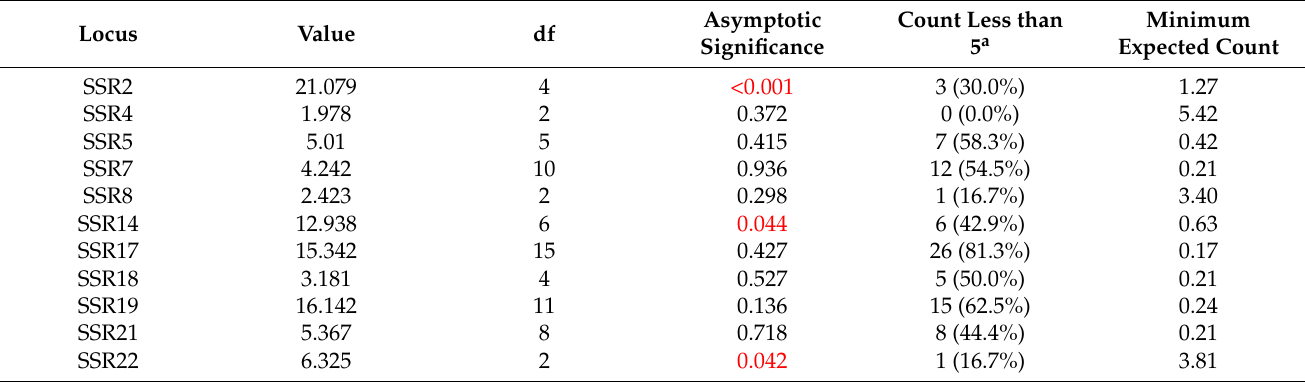
Table 4. Correlation analysis of SSRs and survival rate by chi-square test in strain N2. Total of 11 loci, 3 of the 11 SSRs (SSR2, SSR14, and SSR22) that are statistically significant ( p < 0.05). Df means degrees of